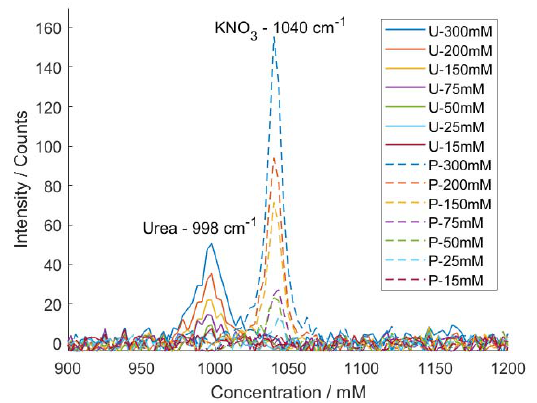
Figure 11. Raman spectra of aqueous urea (U) and KNO 3 (P) solution with a concentration from 15 to 300 mM. The baseline is corrected by subtracting the reference spectrum of water. Each spectrum is obtained over 10 measurements.